Question: What kind of plot is shown here?
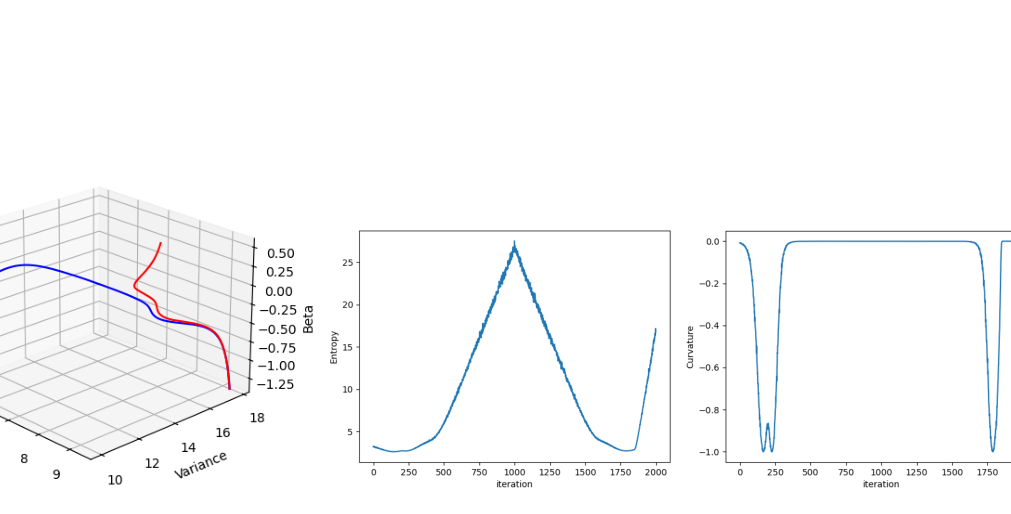
Answer: line